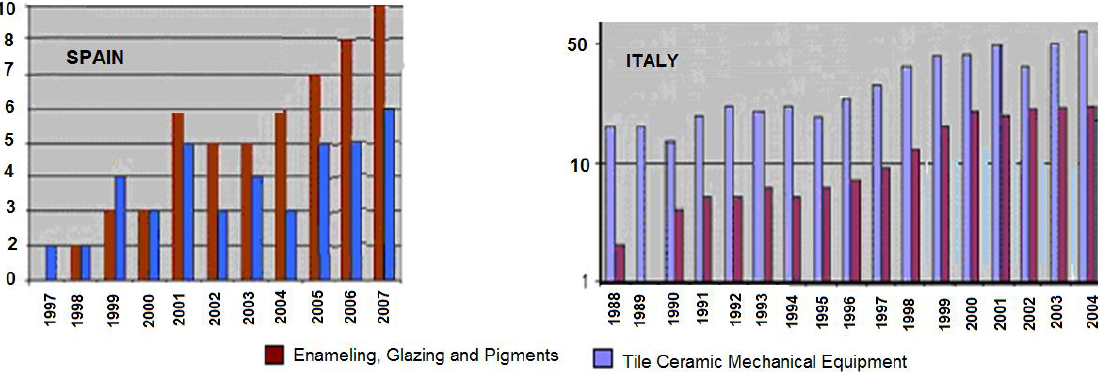
Figure 7. Published patents in the ceramic tile industry, Spain and Italy